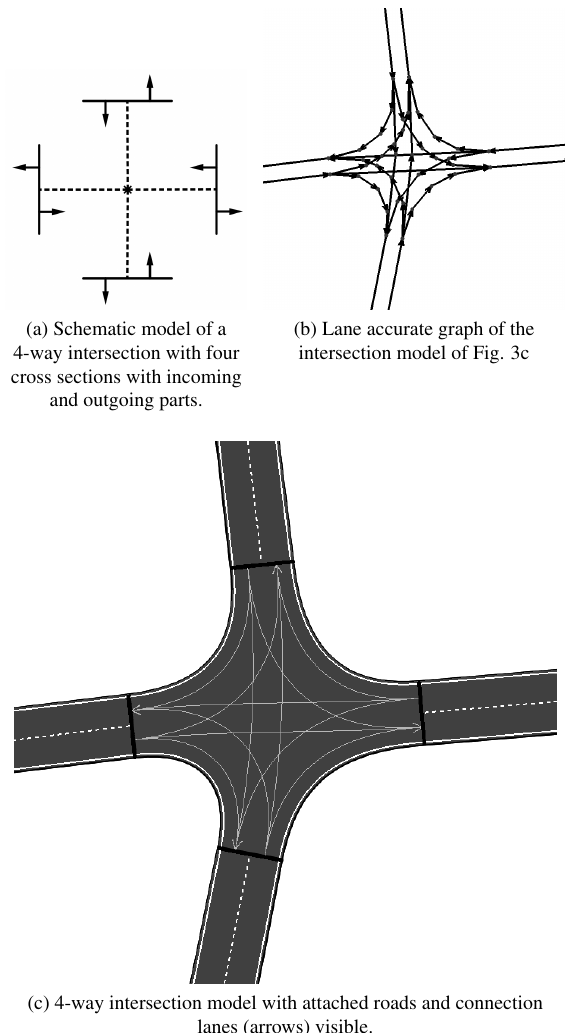
(c) 4-way intersection model with attached roads and connection lanes (arrows) visible. Figure 3. Intersection